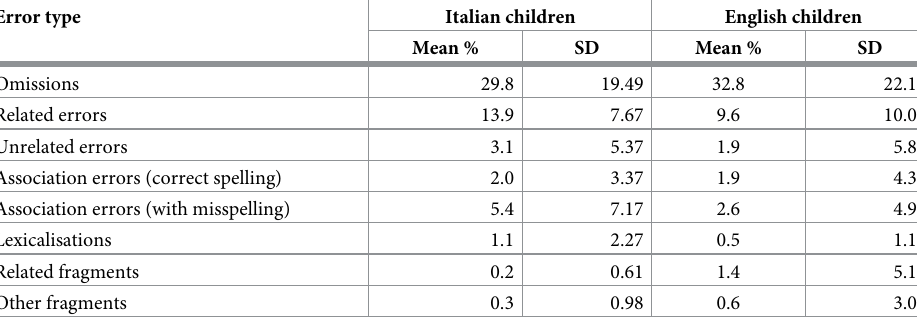
Table 3. Type of errors at the lexical learning